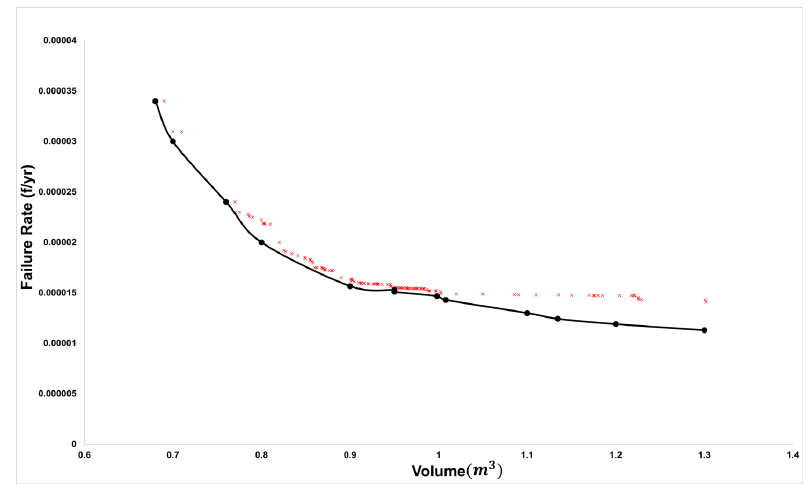
Figure 9. Calculated performance limits of volume and failure rate for MMC. Table 5. Chosen Design Specifics for